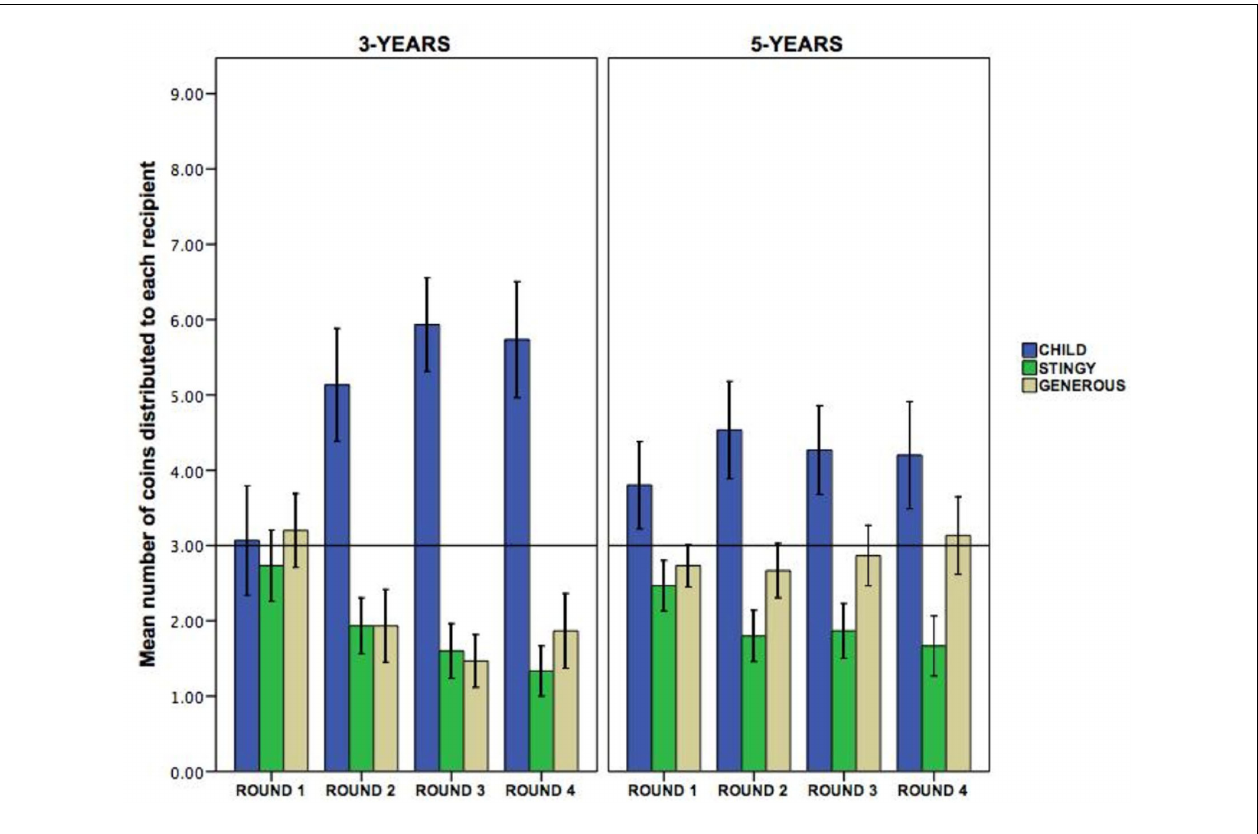
protagonist (child, stingy, and generous) as a function of round (1–4).The horizontal line represents absolute equity (three coins). Bars represent ± 1